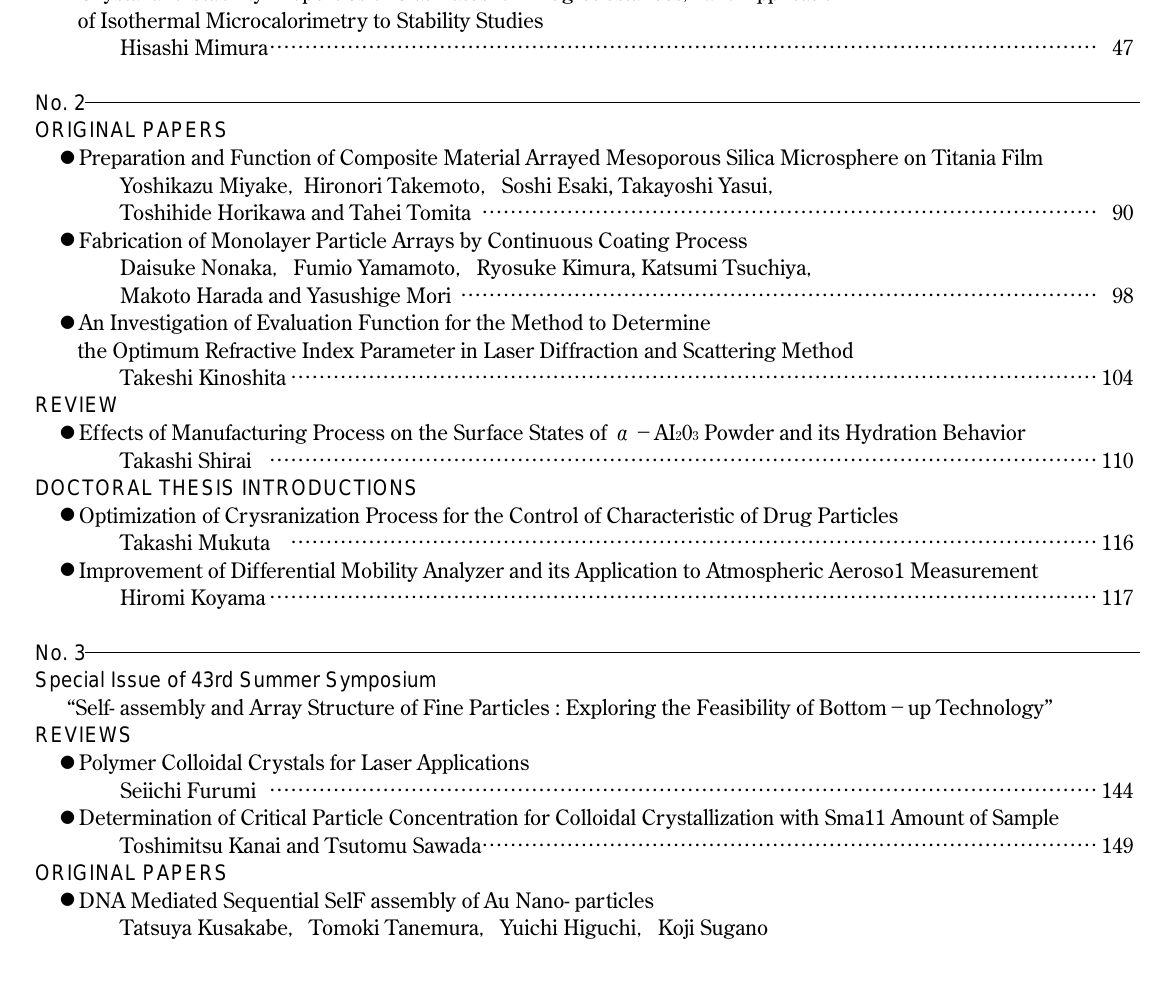
● DNA Mediated Sequential SelF assembly of Au Nano-